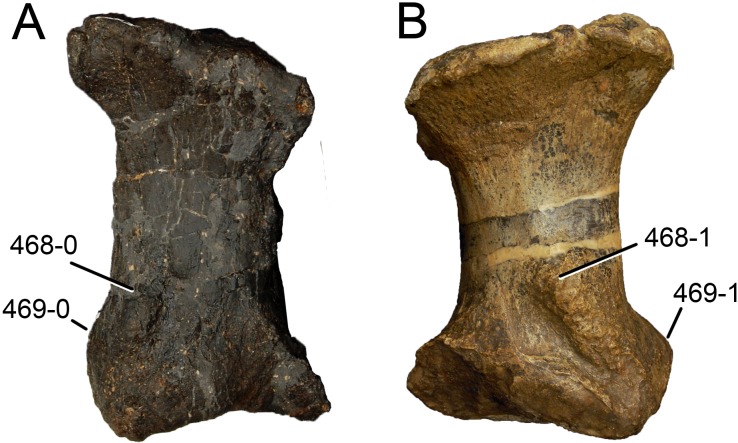
Flagellicaudatan metatarsals II.Right (A) and left (B) metatarsal II of SMA 0087 (A) and Dyslocosaurus polyonychius AC 663 (B) in dorsal/anterior view. Note the dorsolateral rugosity (C465-1) with its different developments (reduced, laterally, A, C468-0; prominent, reaching center or shaft, B, C468-1), or the posterolateral process (absent, A, C469-0; present, B, C469-1). Scaled to same proximodistal length.